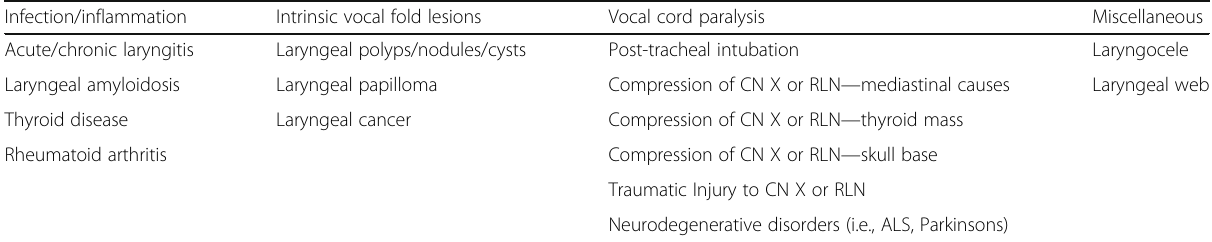
Table 2 Differential diagnosis of vocal cord dysfunction by etiology